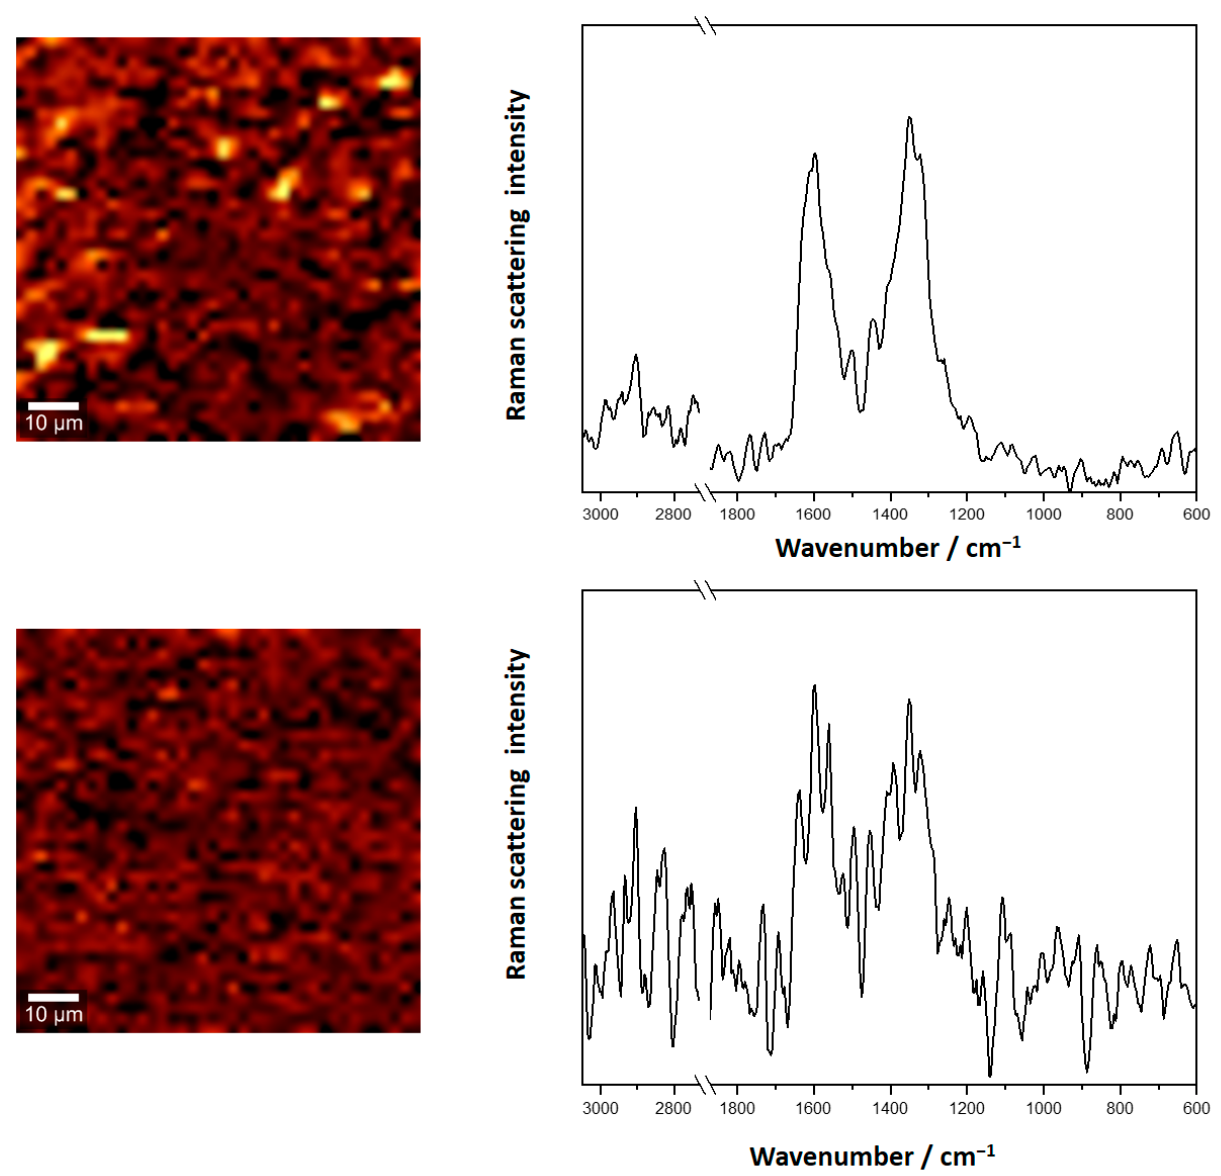
Figure 4. Raman images (integration of D band at 1350 cm − 1 ; sampling density—2 μ m) of PA6/GO_PAAM (top) and PA6/GO (bottom) nanocomposites together with respective Raman spectra.